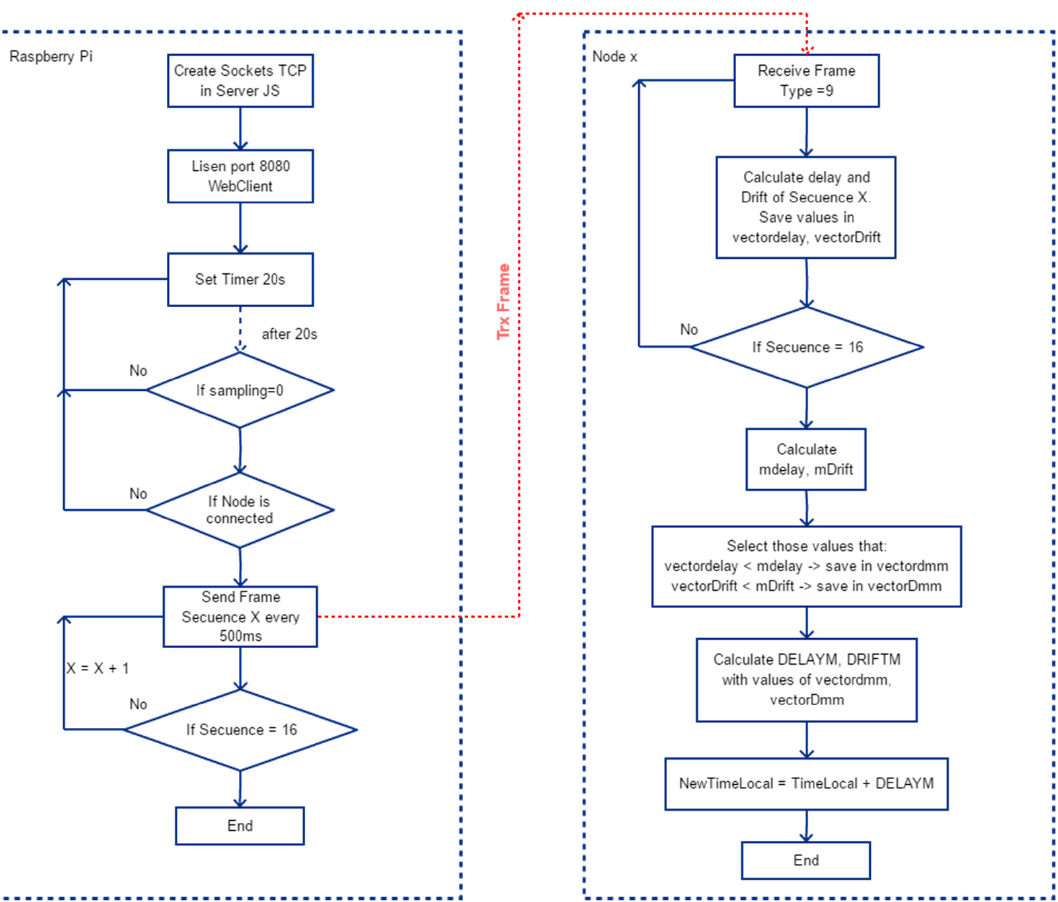
Figure 10. General flowchart of the delay and drift algorithm in phase 1.